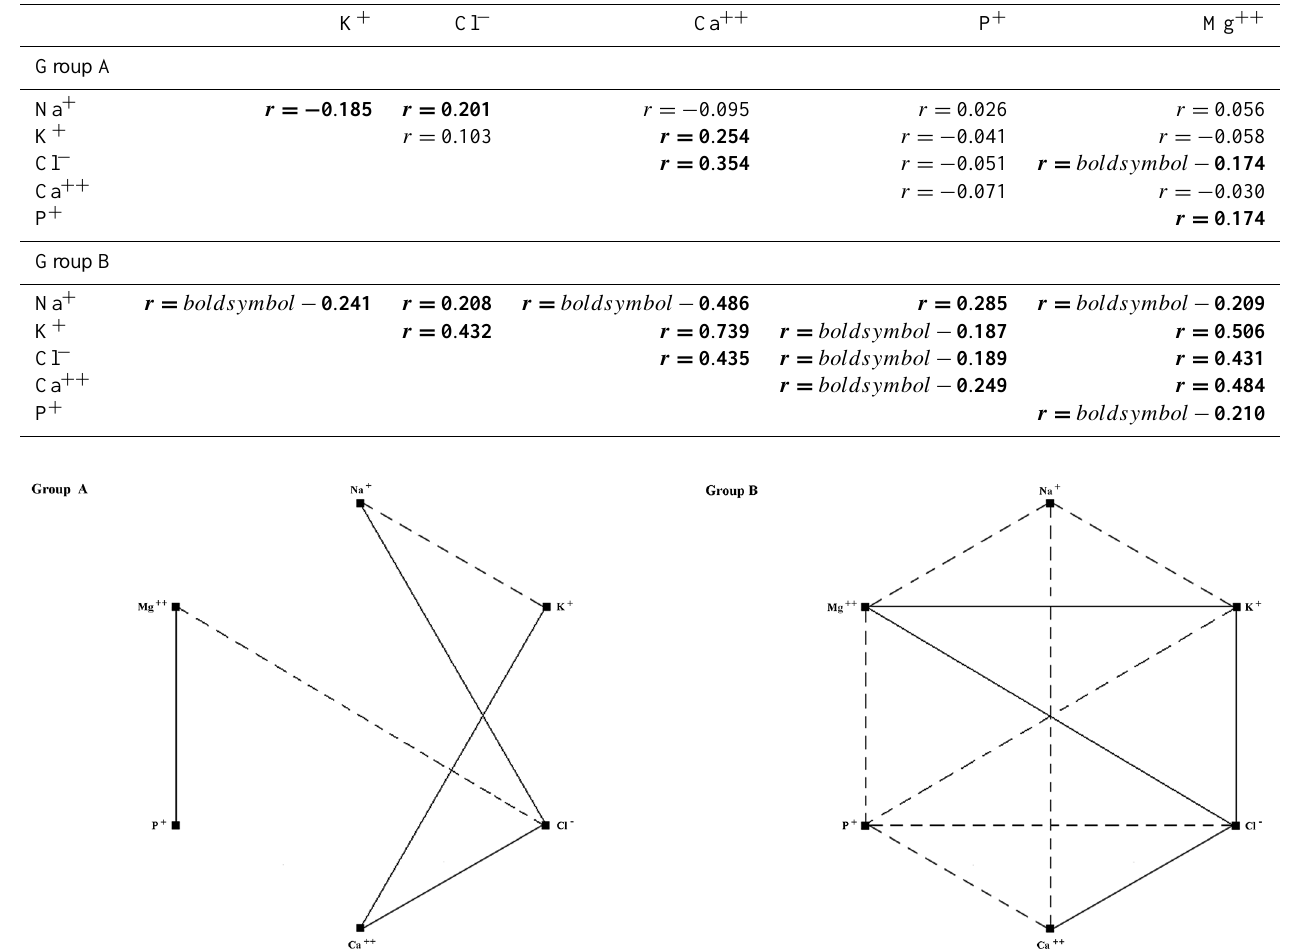
Table 1. Coefficients of correlation between sodium (Na + ), potassium (K + ), Chloride (Cl − ), calcium (Ca ++ ), phosphorus (P + ) and mag- nesium (Mg ++ ) calculated for pregnant (Group A) and control (Group B) mares. Significant correlations ( P < 0 . 05) are indicated in bold